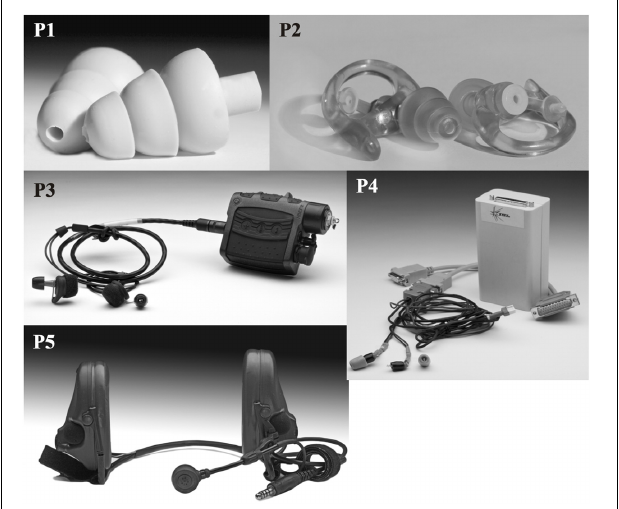
FIGURE 1 | Different HPDs tested in this study (see text for